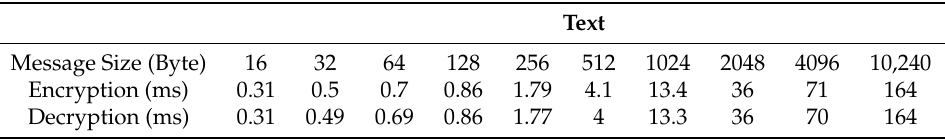
Table 3. Computation time on a smart